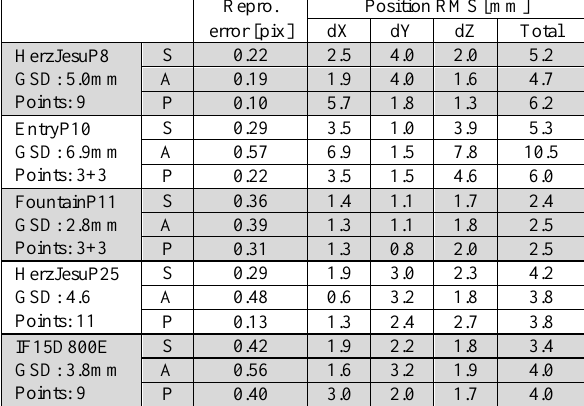
Table 2. RMS of reprojection errors for the targets and deviations between the corresponding 3D reference points and estimated points. The first column lists the number of targets and the mean ground sampling distance (GSD) at the targets. For the datasets EntryP10 and FountainP11, three manually measured natural points have been added to the three automatically measured targets (S: symmetric, A: accumulated, P: PhotoScan).